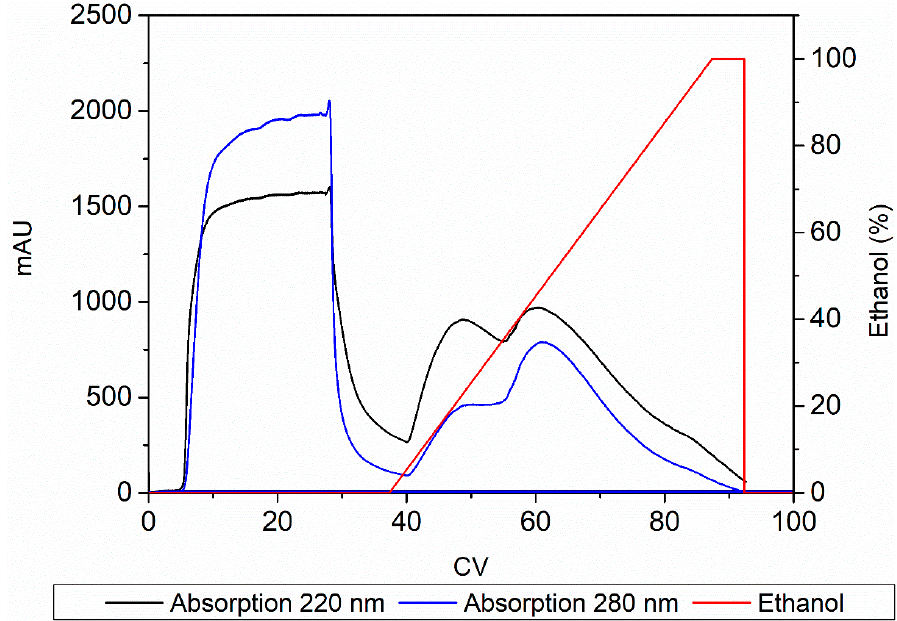
Figure 4. FPLC chromatogram showing absorption signals at 220 and 280 nm spanning the linear elution gradient of ethanol. elution gradient of